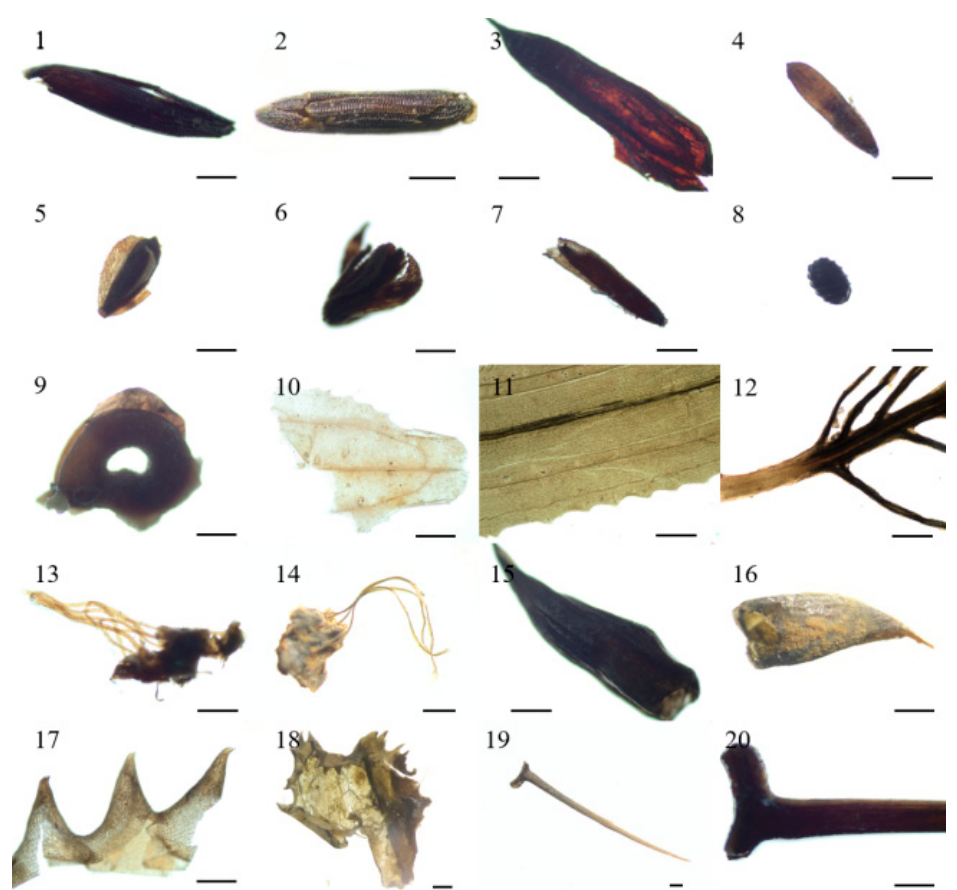
Figure 4. Images of dominated plant macrofossils in Huanggai Lake, with each unit scale as 0.5 mm.